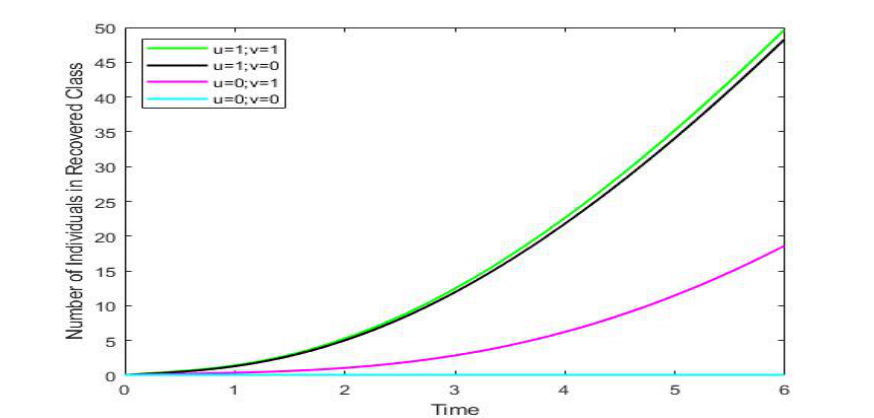
Figure 9: Recovered class for various values of control